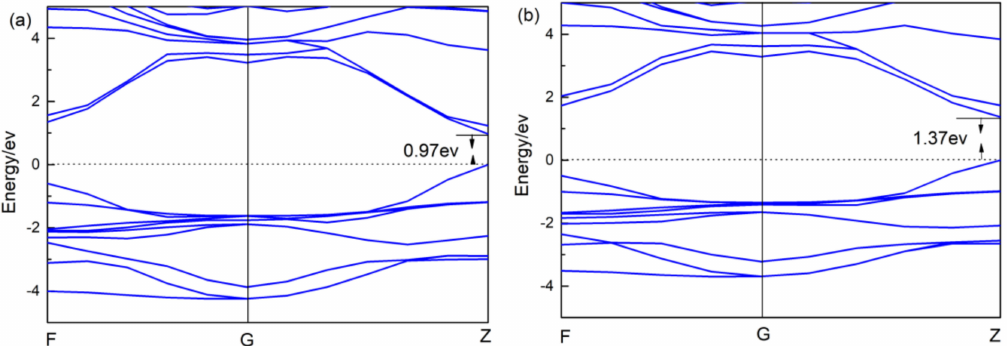
Figure 4. The band structure of CsGeI 3 under the pressure of ( a ) 0 GPa and ( b ) − 0.5 GPa.